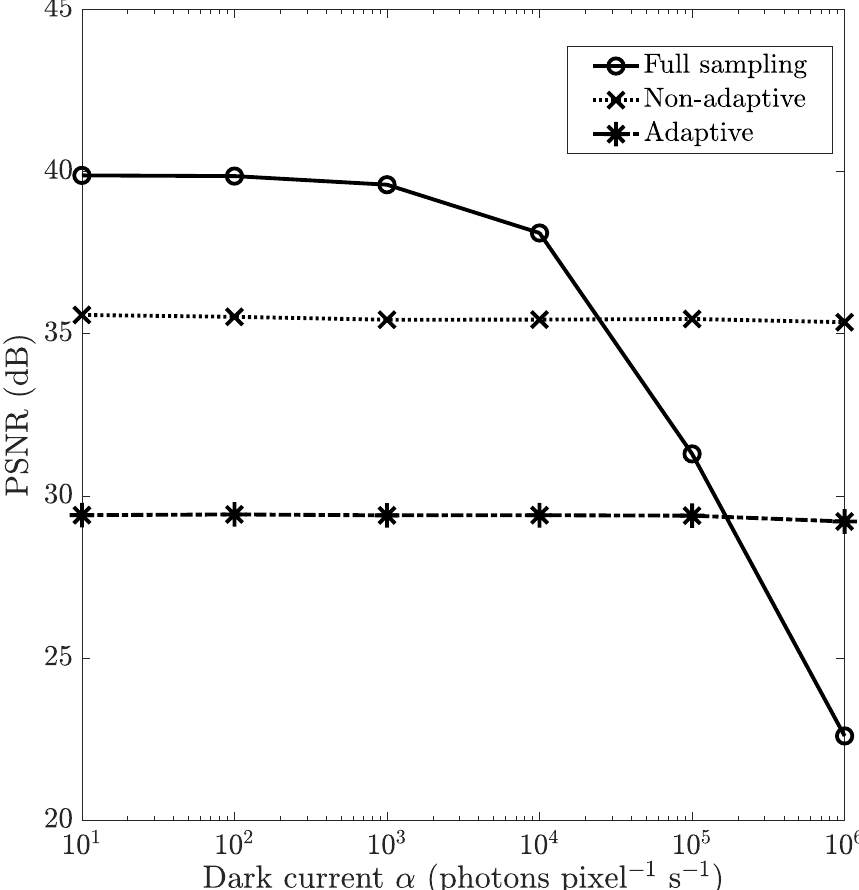
Figure 6. The effect of dark current α on the reconstructed image PSNR of the U2OS cell scene for multitrack full sampling, multitrack non-adaptive CS and multitrack adaptive CS. The max scene intensity is fixed at 5 × 10 4 photons s − 1 voxel − 1 , and the integration time is 0.1